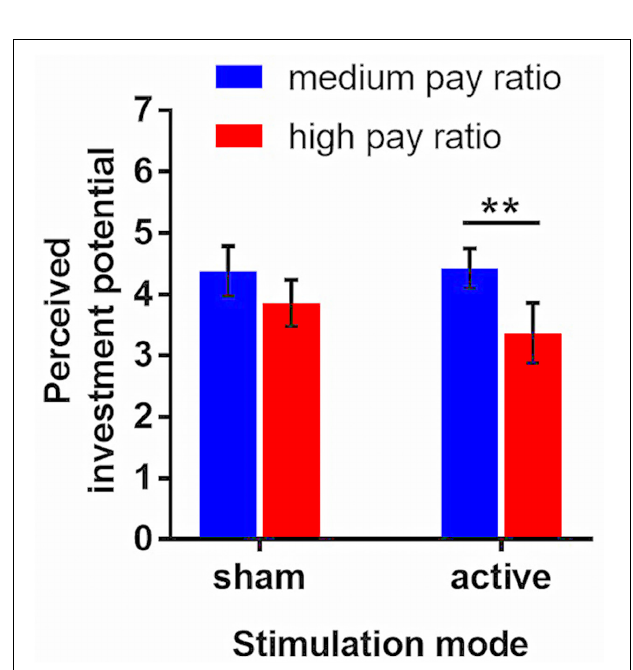
FIGURE 3 | The means of the perceived investment potential in different treatments. The error bars indicate 95% confidence intervals. The asterisks indicate statistically significant differences (** 0.01). Sham-medium vs. sham-high: p = 0.751; active-medium vs. active-high: p =